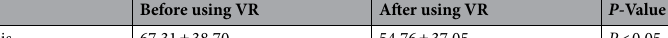
Before using VR After using VR Parallax angle of stereopsis Table 4. The parallax angle of stereopsis changes, in unit arc/sec, before and after the use of VR for watching 3D videos.